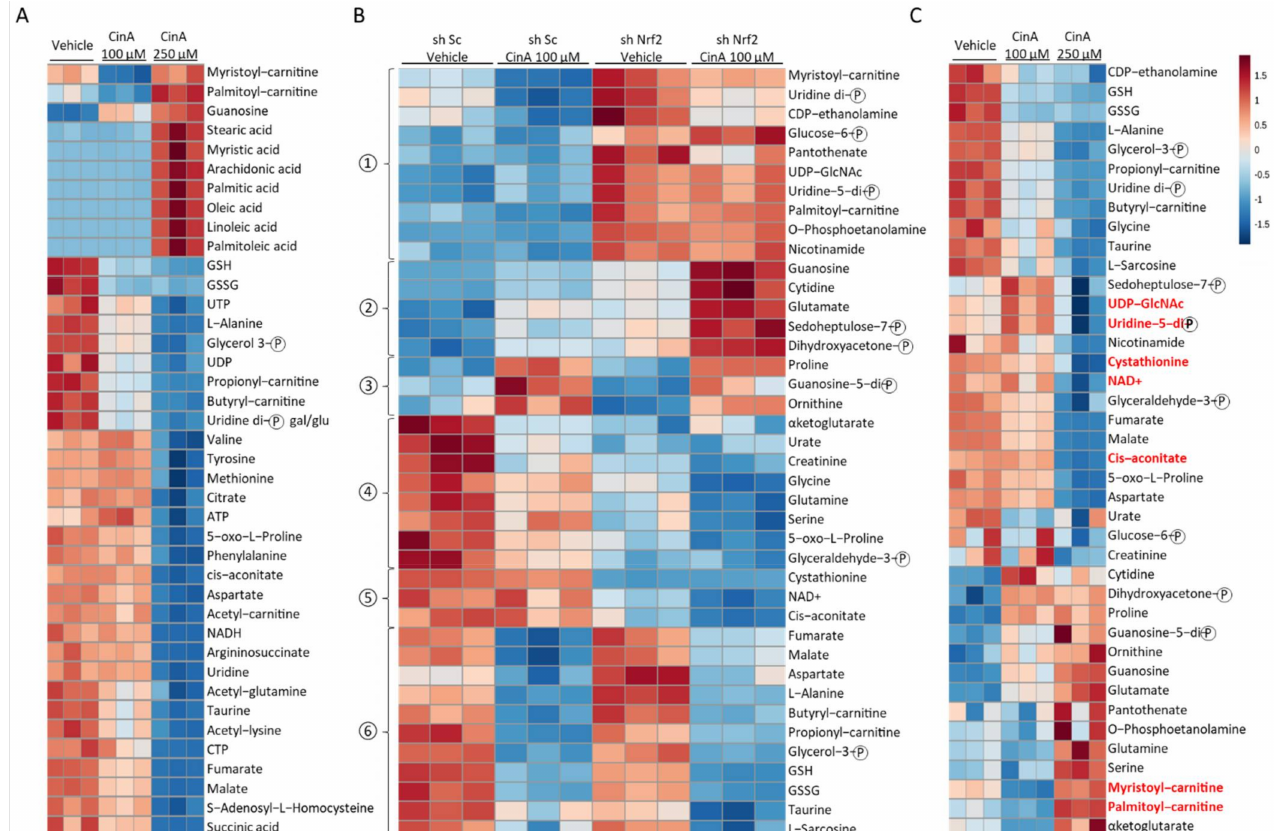
Figure 5. CinA and Nrf2 modify intracellular metabolites profiles in KCs. KCs were invalidated for Nrf2 by transduction with lentiviral particles to express a short-hairpin RNA targeting Nrf2 (sh Nrf2) or a scrambled short-hairpin (sh ctrl) as the control cells, and the cells were exposed to 100 or 250 µ M of CinA for 1 h, followed by a metabolomic analysis by mass spectrometry. ( A ) Heatmap representing the 40 highest and most significant p -values from the comparison of sh ctrl cells exposed to CinA (100 or 250 µ M) and DMSO 0.1% as the control. ( B ) Heatmap representing the 40 highest and most significant p -values from the comparison of sh ctrl and sh Nrf2 cells exposed to 100 µ M of CinA or DMSO 0.1% as the control. ( C ) Heatmap representing the same metabolites as panel B for the comparison of sh ctrl cells exposed to CinA (100 or 250 µ M) and DMSO 0.1% as the control. Data represent the results of 3 independent